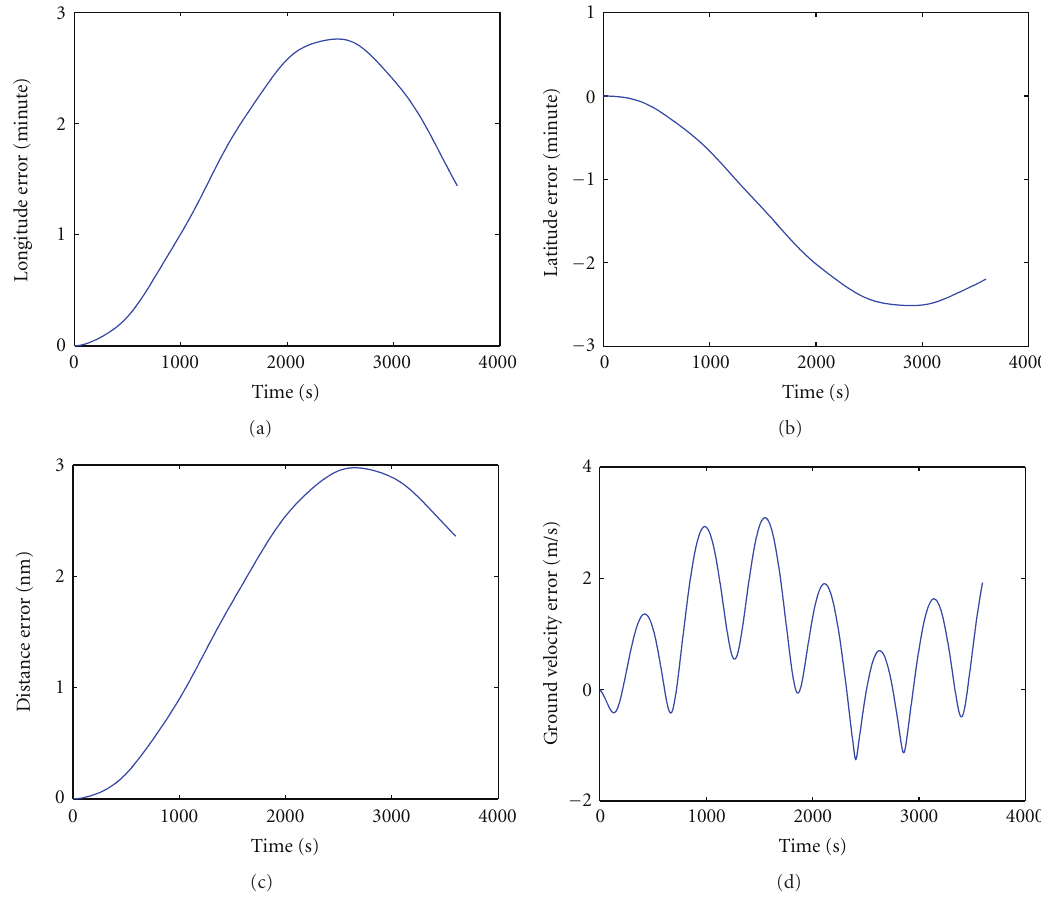
Figure 17: Position and velocity error of circle